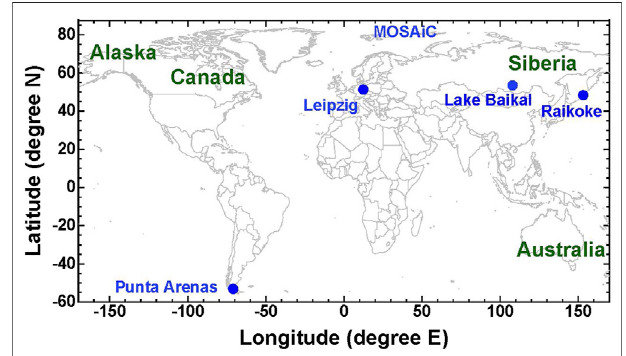
FIGURE1| Mapshowingtheground-based lidarstationsatLeipzigand Punta Arenas, Lake Baikal (circle indicates coordinates of lake center), the High Arctic MOSAiC measurement area, and the location of the Raikoke volcano in the Kuril Islands. Strong wild fi res occurred at mid to high northern latitudes in Alaska, Canada, and Siberia in 2019 and in southeast Australia in December 2019 and January